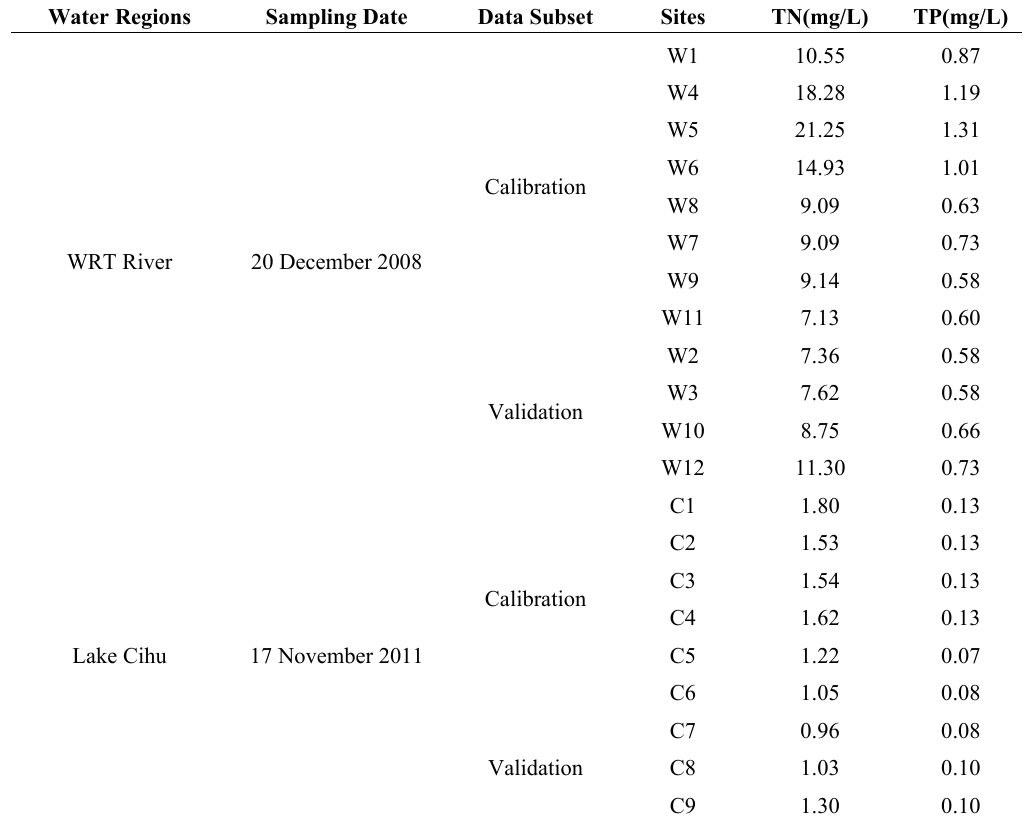
Table 2. TP and TN concentrations obtained from the different sampling sites identified in Figure